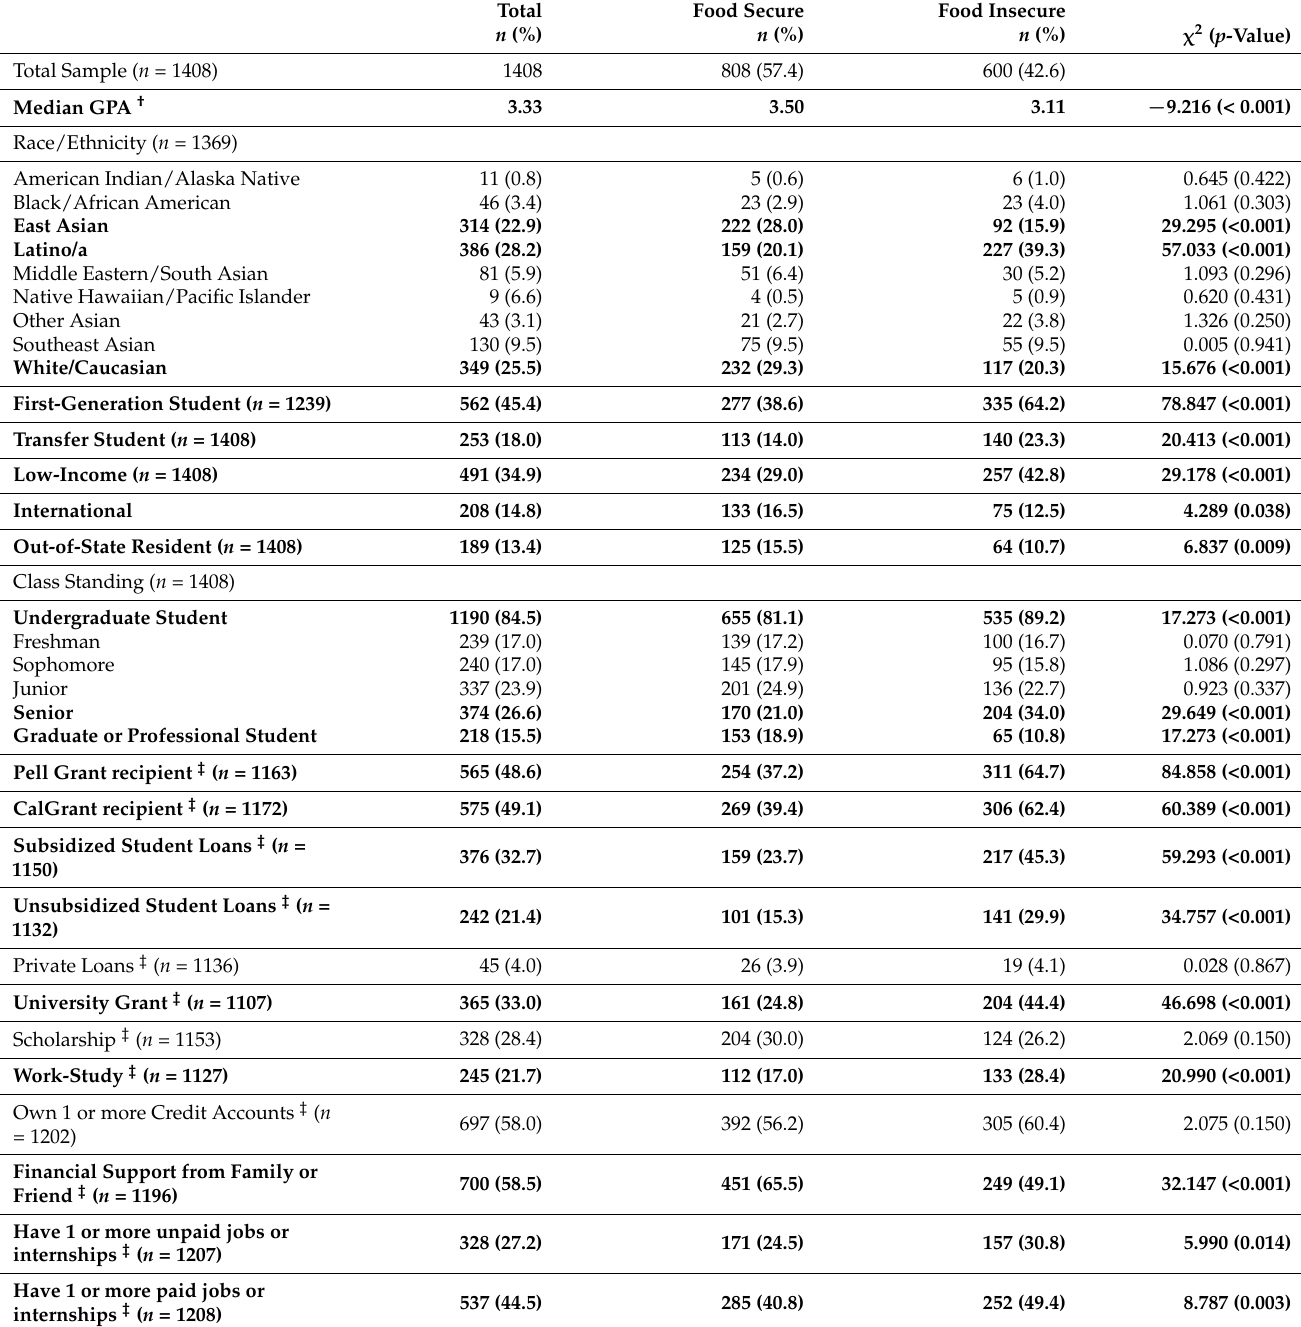
Table 1. Demographic and Financial Characteristics of